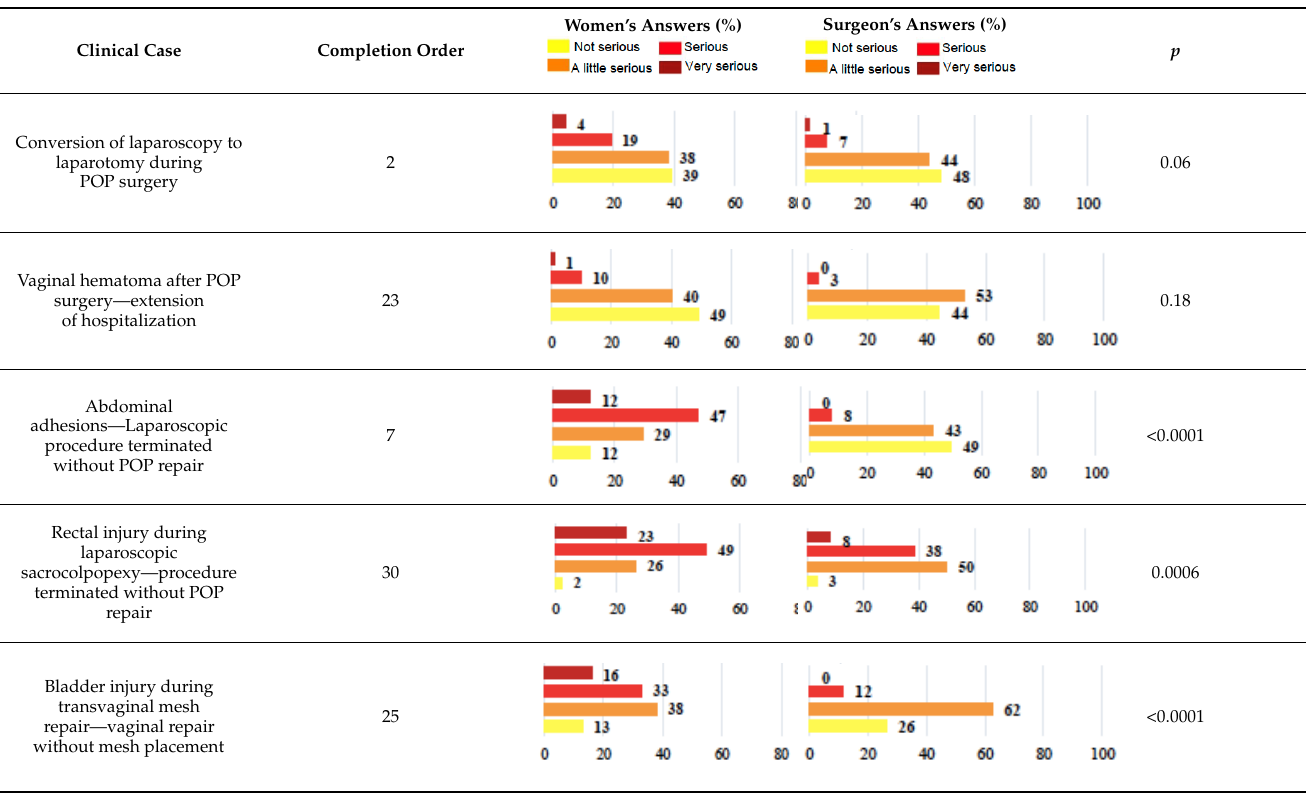
Table 3. Description and comparison of women’s and surgeons’ answers (percentages and Fisher’s exact test)—unclassifiable vignettes.